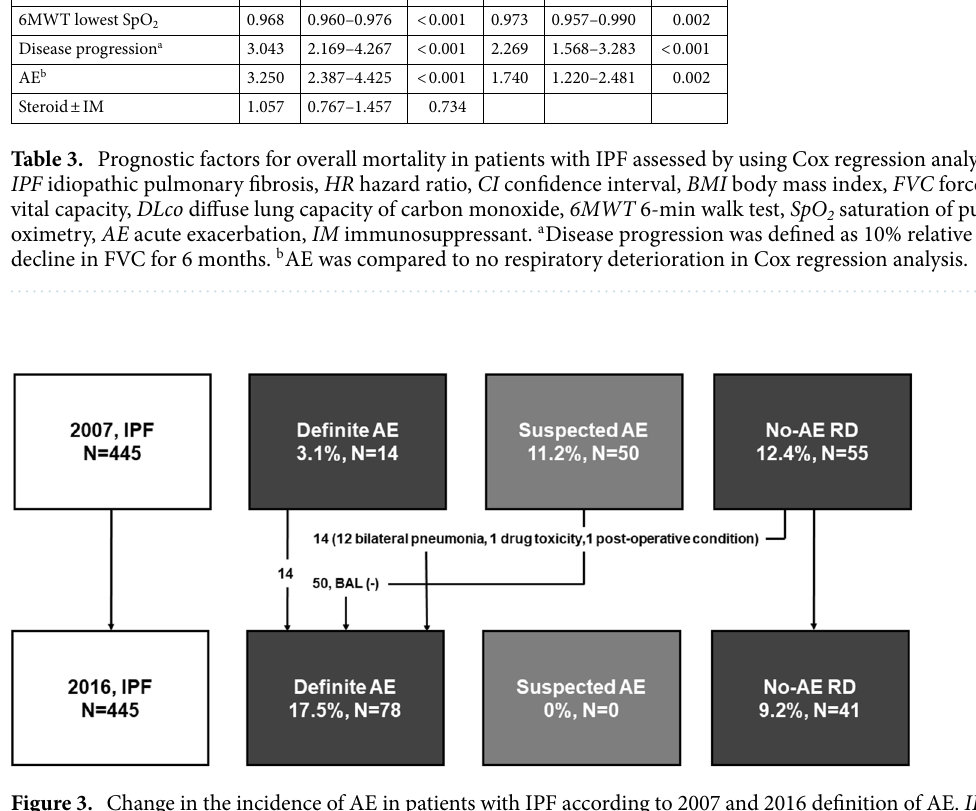
Figure 3. Change in the incidence of AE in patients with IPF according to 2007 and 2016 definition of AE. IPF idiopathic pulmonary fibrosis, AE acute exacerbation, RD respiratory